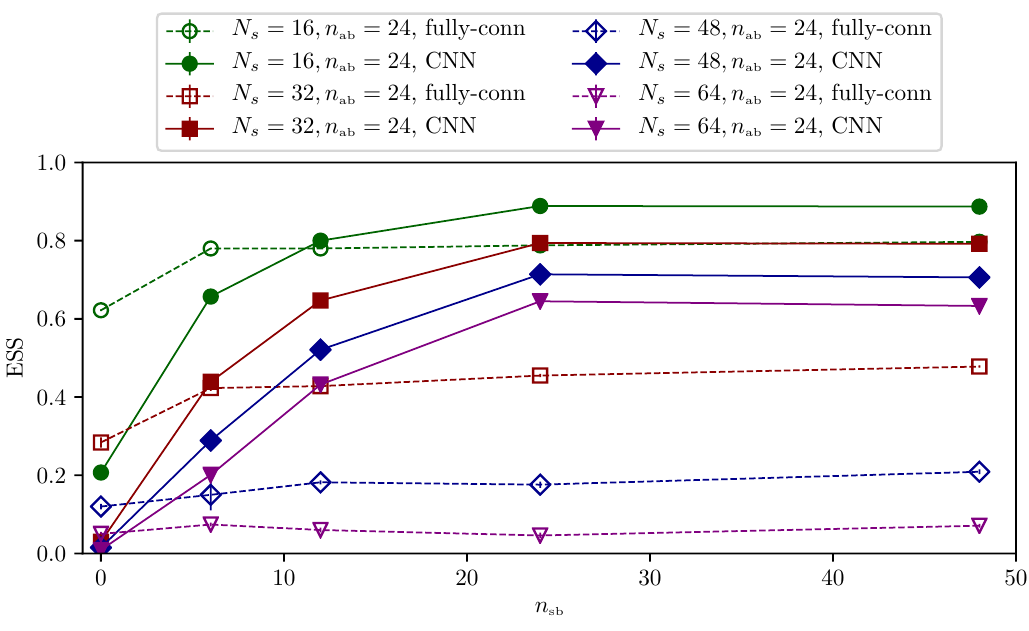
Figure 5 . Comparison of effective sample size for N s × 8 lattices between SNFs with fully connected networks (empty points) and CNNs (full points), at κ = 0 . 2 , λ = 0 . 022 . Training duration is the same as in figure